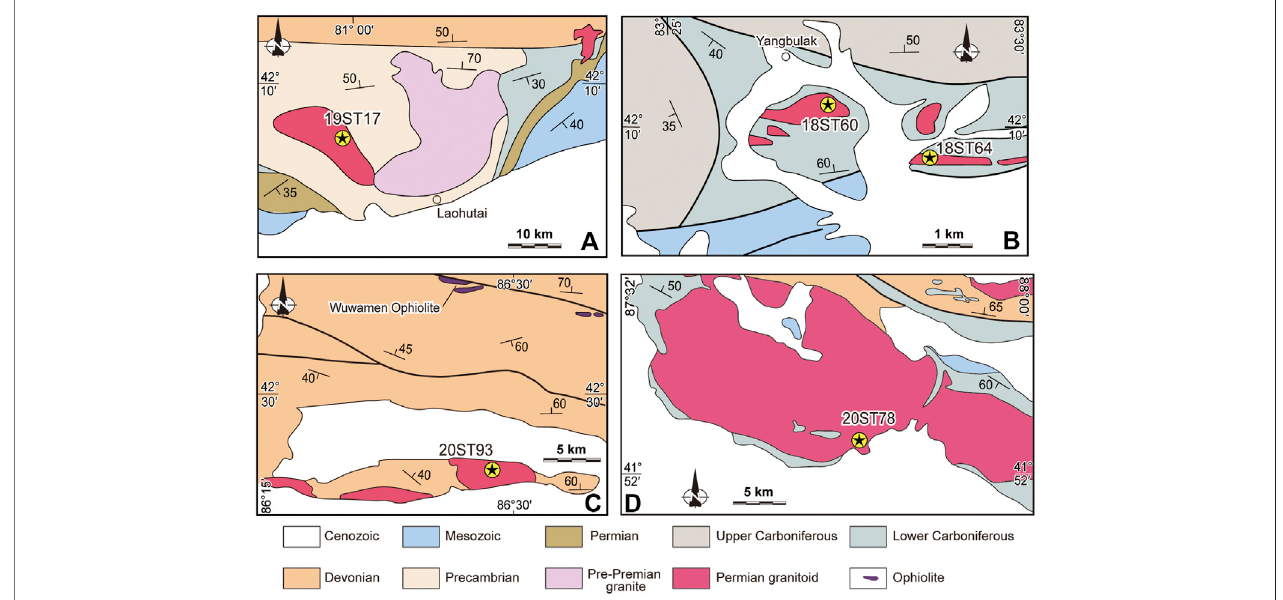
FIGURE 2 | Simpli fi ed geological maps of studied areas showing distribution of Permian granitoids and sampling sites. (A) Geological map of the Laohutai area (modi fi ed after Wang, 2007a); (B) Geological map of the Yangbulak area (modi fi ed after BGMRXUAR, 1975a); (C) Geological map of the Hejing area (modi fi ed after BGMRXUAR, 1975b); (D) Geological map of the area east of Lake Baghrash (modi fi ed after BGMRXUAR,